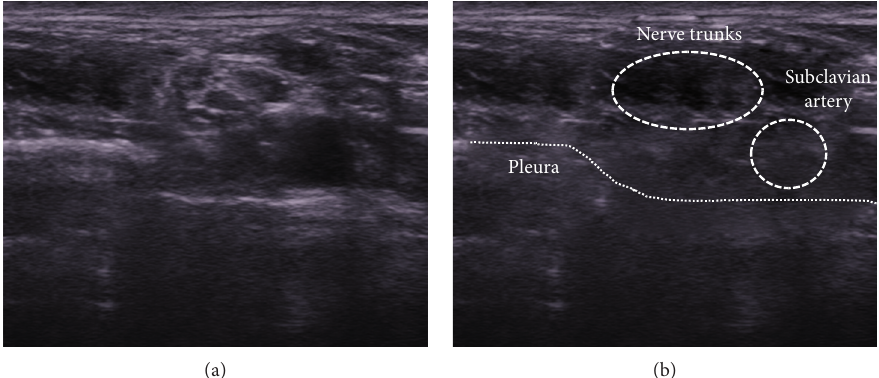
Figure 4: In the supraclavicular view, the linear hyperechoic pleura and hypoechoic lung are depicted, and the nerve trunks adjacent to the subclavian artery are